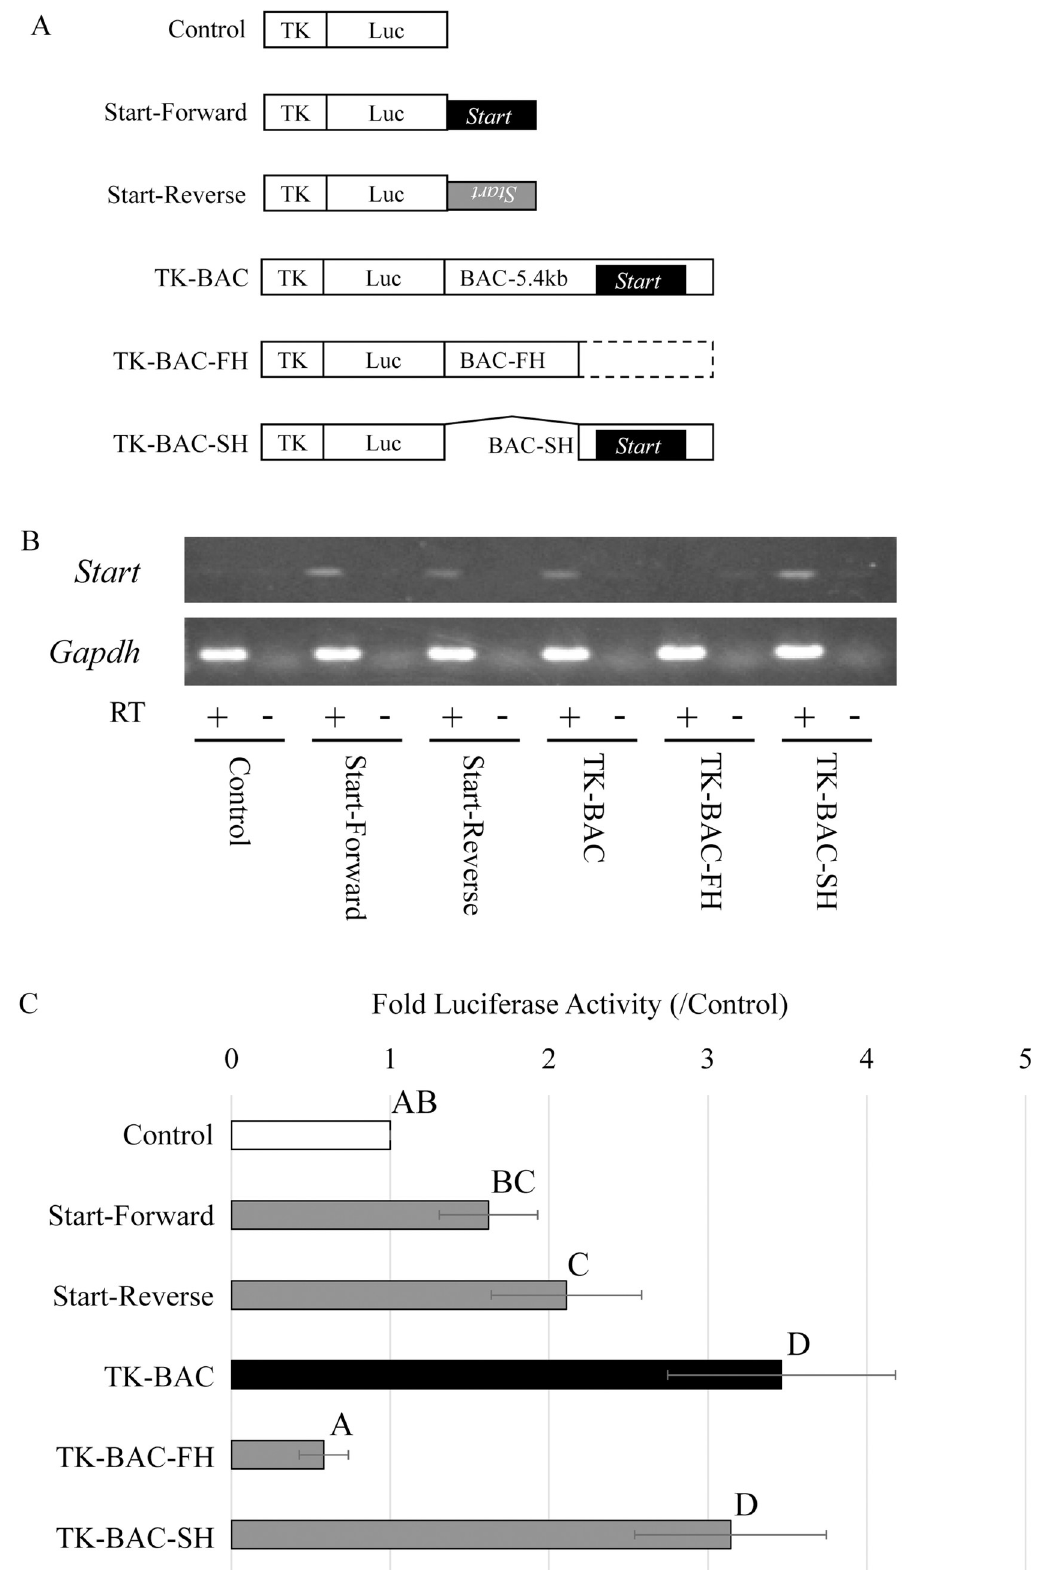
Fig 4. Enhancer activity of parts of the BAC-5.4kb sequence. (A) Reporter constructs used in (B) and (C). “Control” and “TK-BAC” were described in the legend of Fig 2A. The “Start-Forward” and “Start-Reverse” constructs contained the Start sequence downstream of the firefly luciferase gene (Luc) driven by the TK promoter in the forward and reverse directions, PLOS ONE | https://doi.org/10.1371/journal.pone.0273279 August 25,